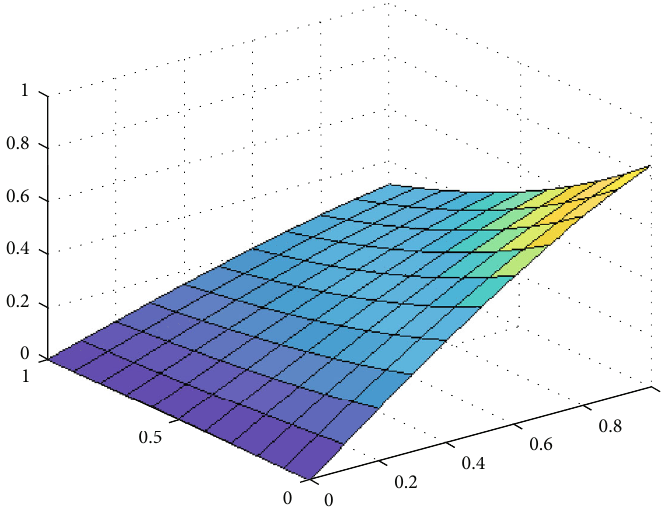
Figure 1: The exact solutions ψ ð x , t Þ = φ ð x , t Þ for equation (50) when α = β = 1